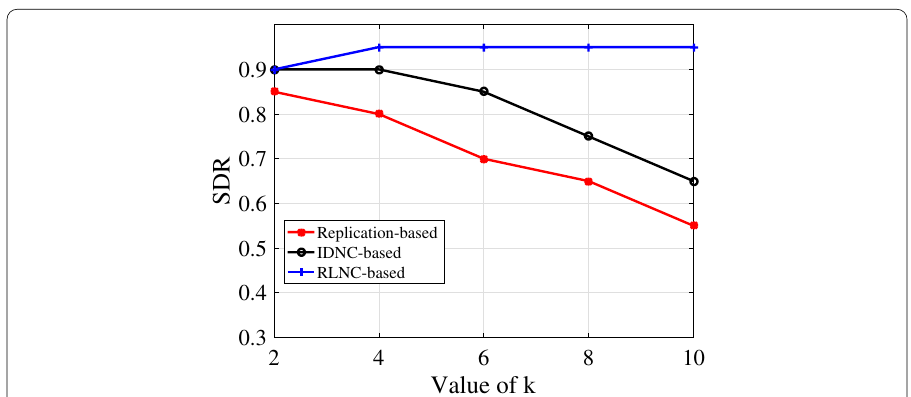
Fig. 13 The relation between the redundancy rate and the SDR of